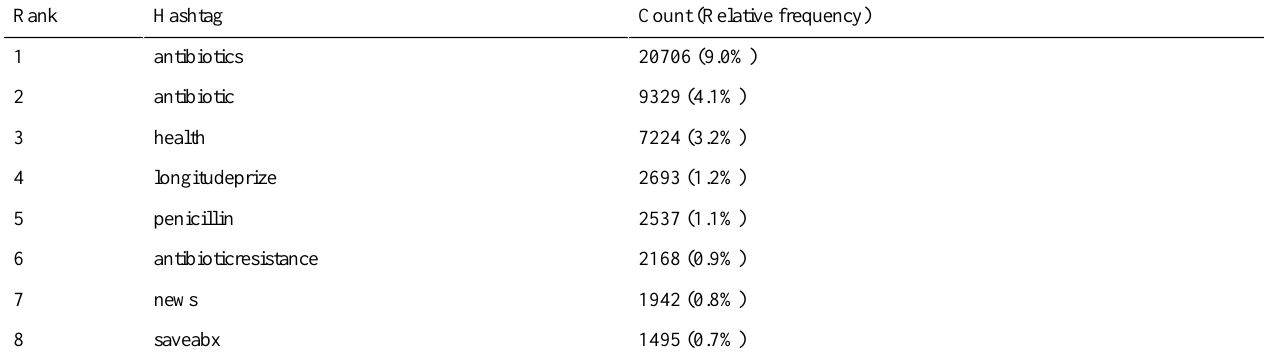
Table 3. Usage of the most common hashtags from collected set of antibiotic-related tweets.